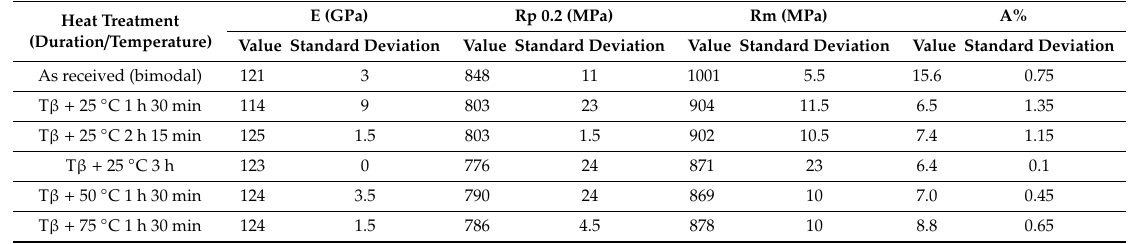
Figure 8. Engineering ( a ) and True ( b ) stress strain curves of the six microstructures. Table 3. Mean static properties of the six microstructures.